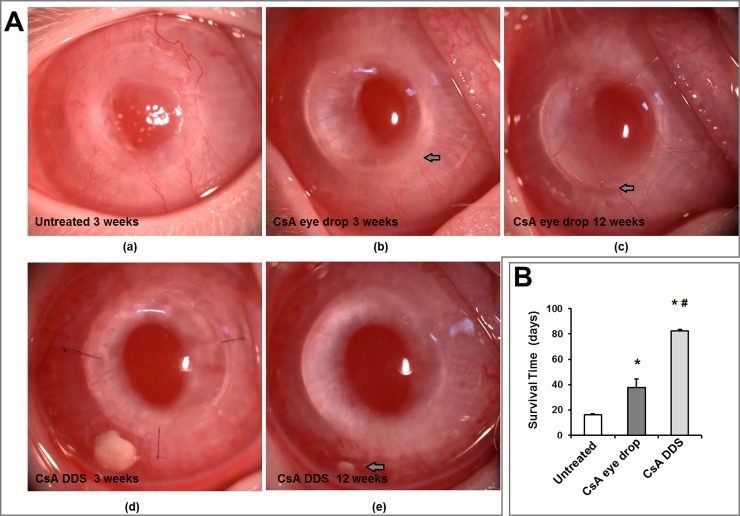
The slit lamp micrographs and corneal graft survival time.(A) Representative slit lamp micrographs showed the corneal status in the untreated, CsA eye drop, and CsA DDS groups at 3 and 12 weeks postoperatively, respectively. (a) Rejected corneal allograft in the untreated group on postoperative week 3, with severe corneal edema and neovascularization. (b-c) Clear corneal allograft with neovasculature invading the graft-host junction (arrow), and mild graft edema with extensive neovasculature invading the graft (arrow) in the CsA eye drop group on postoperative weeks 3 and 12, respectively. (d-e) Clear corneal allografts in the CsA DDS group on postoperative weeks 3 and 12, with the DDS dissolved gradually (arrow). (B) The mean survival time (days) of the corneal allografts in different groups. Data are presented as mean ± SD. * p < 0.01 vs. untreated, # p < 0.01 vs. CsA eye drops (n = 10 per group).